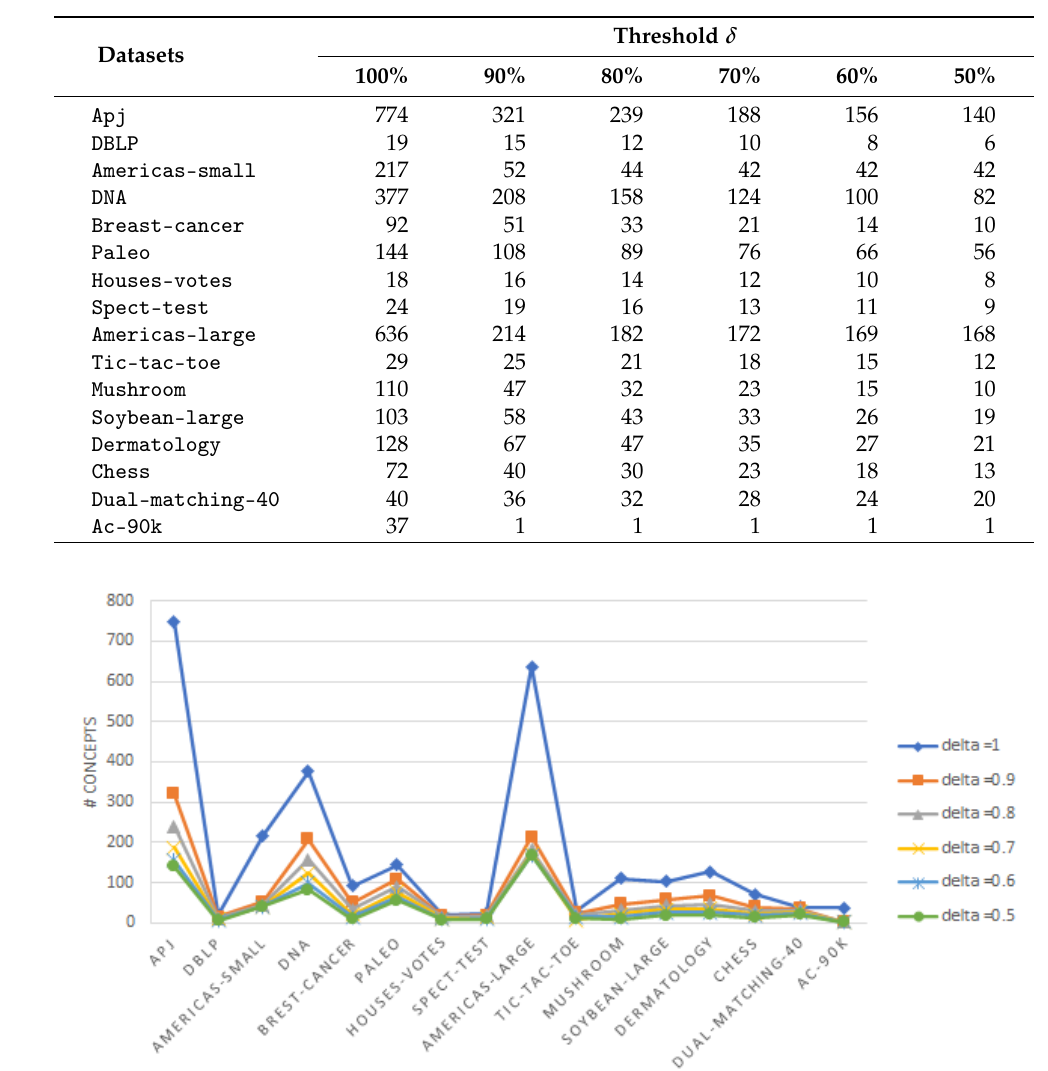
Table 9. The number of concepts of the C ONCISE algorithm with different thresholds.